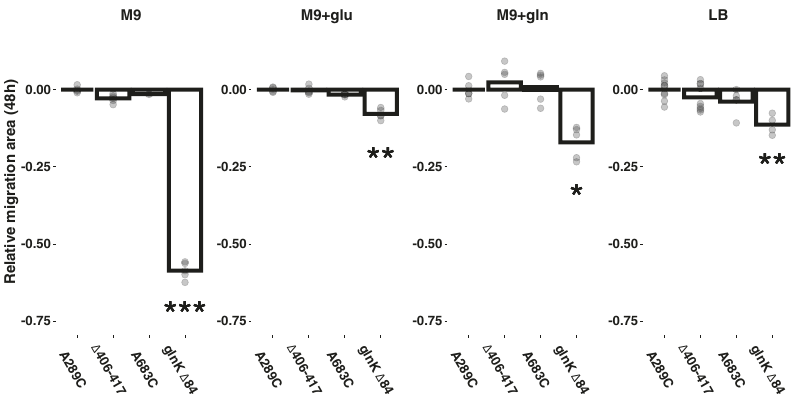
Fig. 3 ntrB mutants possess comparable motility phenotypes. Surface area of motile zones within an AR2 genetic background following 48 h of growth across four environmental conditions for mutants ntrB A289C, ntrB Δ 406-417, ntrB A683C and glnK Δ 84; rpoN A688C. Lysogeny broth (LB, N = 9, 9, 5, 4 respective independent biological replicates), M9 minimal media with ammonia (M9, N = 7, 6, 2, 5), and M9 supplemented with amino acids glutamate (M9 + glu, N = 5, 5, 5, 4) or glutamine (M9 + gln, N = 5, 5, 5, 6) were used as nutritional conditions. Individual data points from biological replicates are plotted and each migration area has been standardised against the surface area of an AR2 ntrB A289C mutant grown in the same environment ( ntrB A289C growth mean = 0). Signi fi cance values for glnK Δ 84; rpoN A688C: M9 P = 0.000708,M9 + glu P = 0.0025, M9 + gln P = 0.032, LB P = 0.0048 (Kruskal – Wallis post-hoc Dunn test, one-sided). Source data are provided as a Source Data fi